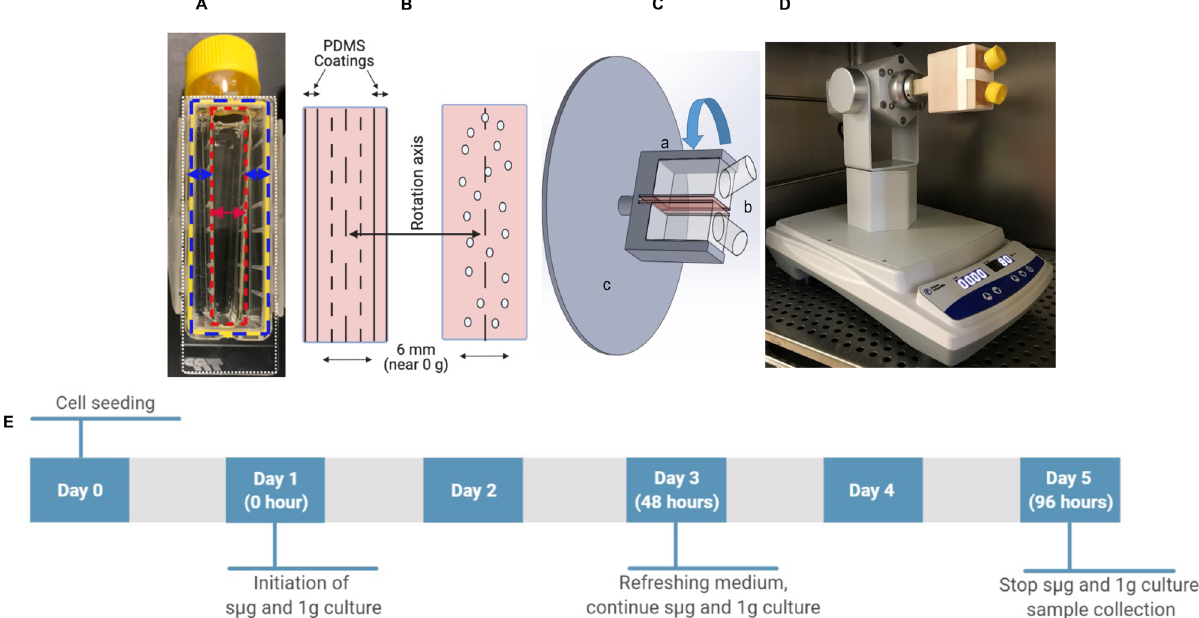
Fig. 1 Experimental setup to simulate microgravity. A Clipmax chamber-slide fl ask with a small cell culture channel created (represented by a red double-sided arrow) after fi lling the two sides (represented by two blue double-sided arrows) and the top of the chamber-slide fl ask (not shown) with PDMS. B Distribution of microgravity forces in relation to the rotation axis at the area where cells are cultured. Oval circles represent cells. C Illustration of the developed device to simulate microgravity: ( A ) indicates 3-D printed adapter connecting two cell culture fl asks ( B ) to the spinning bolt of a sample rotator instrument. C Indicates the bottom surfaces of the fl asks where cells are attached (illustrated in red), which are positioned back-to-back and located in the axis of rotation. D Our developed rotary cell culture system (RCCS) with 2 fl asks af fi xed to the system and located inside of the cell culture incubator, ready to generate simulated microgravity. E Experimental design used in this